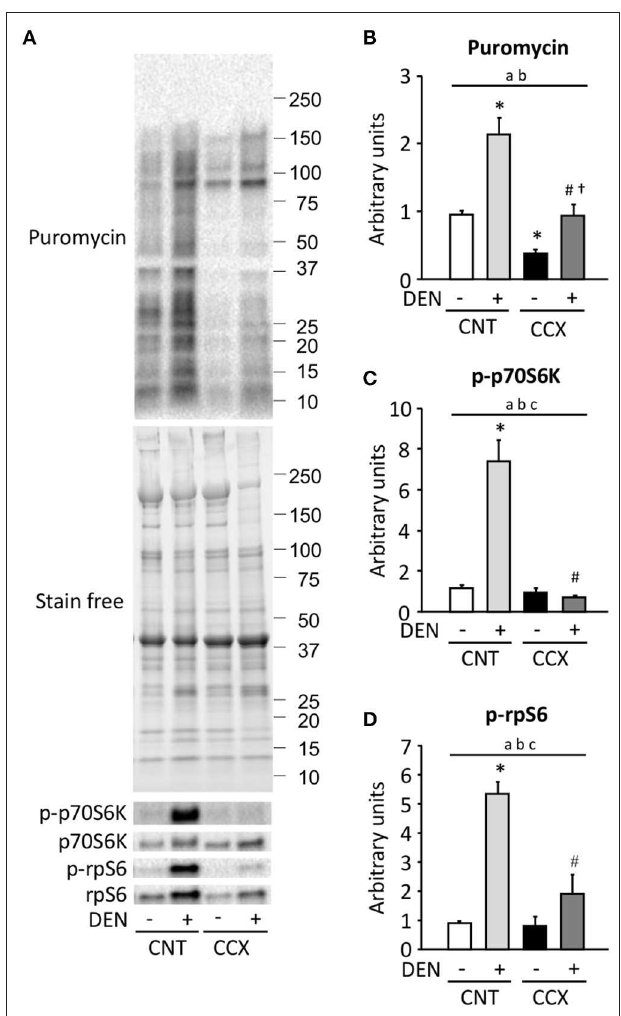
FIGURE 4 | Cancer cachexia inhibits the activation of protein synthesis and the mTORC1 signaling in denervated mouse gastrocnemius muscles. Representative western blots for puromycin, total and phosphorylated p70S6K Thr389 (p-p70S6K), and total and phosphorylated rpS6 Ser240/244 (p-rpS6) in control (CNT) and cancer cachexia (CCX) mice, with or without denervation (DEN) (A) . The expression levels of puromycin was normalized to the whole proteins in stain free images and expressed as fold change of the mean CNT value, which was set to 1 (B) . The levels of p-p70S6K (C) and p-rpS6 (D) were normalized to total p70S6K and rpS6 content, respectively. Data show mean ± SEM for 6–7 muscles per group. Statistical significance was set at P < 0.05: main effect of a CCX and b DEN; c interaction of CCX and DEN; difference vs. *CNT without DEN, # CNT with DEN, and † CCX without